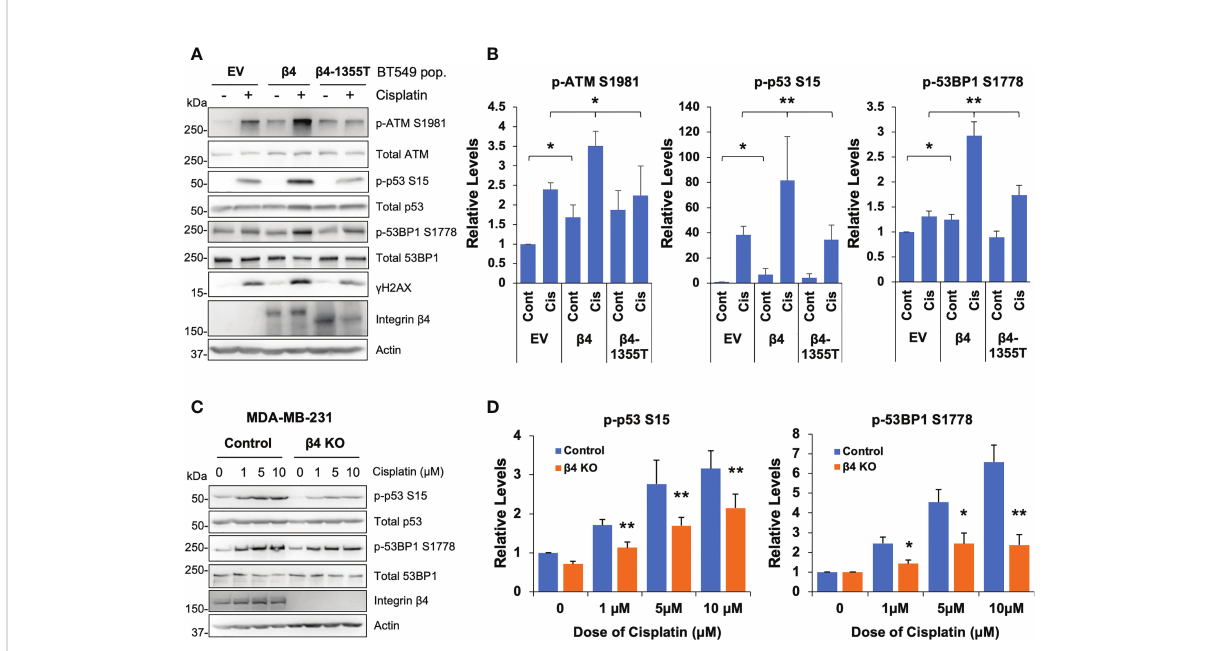
FIGURE 2 Integrin a 6 b 4 promotes activation of ATM-p53-53BP1 in response to cisplatin that results in enhanced DNA damage. (A) BT549 cells (EV, b 4, and b 4-1355T) were plated on laminin-1 and treated with 10 m M cisplatin for 24h prior to assessing for phosphorylation of indicated DDR proteins, as noted. Fold differences in pATM S1981, p53BP1 S1778 and p-p53 S15 were quanti fi ed from three separate experiments and reported relative to BT549 EV control (B) . (C) MDA-MB-231 control or b 4 KO (clone 454-1) cells were treated with indicated dose of cisplatin for 24h as in (A) and immunoblotted for the indicated phospho-proteins and total proteins. Fold changes in noted phosphorylation sites are reported after normalization to total protein and reported relative to MDA-MB-231 control treatment in (D) . *p < 0.05, **p <